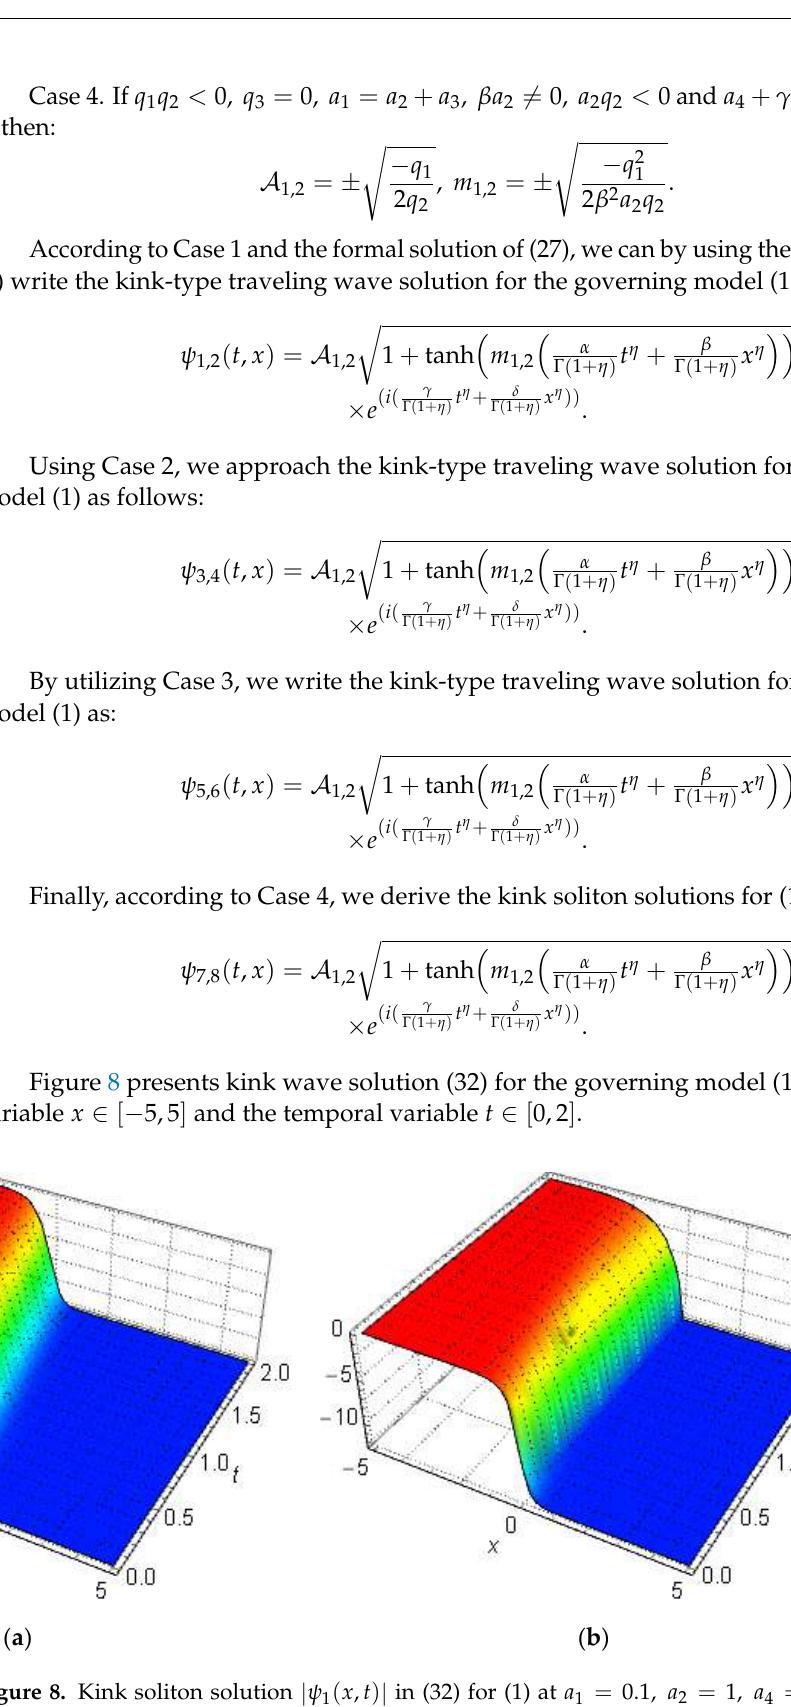
( b ) Figure 9. Kink soliton solution (cid:3627) 𝜓 8 ( 𝑥, 𝑡 )(cid:3627) in (35) where 𝑎 1 = 0.1, 𝑎 3 = 1, 𝑞 1 = 0.9, 𝑞 2 = 0.1, 𝛼 = 0.1, 𝛽 = 0.1, 𝛾 = 0.1, 𝛿 = 0.1 at: ( a ) 𝑡 = 0.5 ; ( b ) 𝑡 = 1.5 .